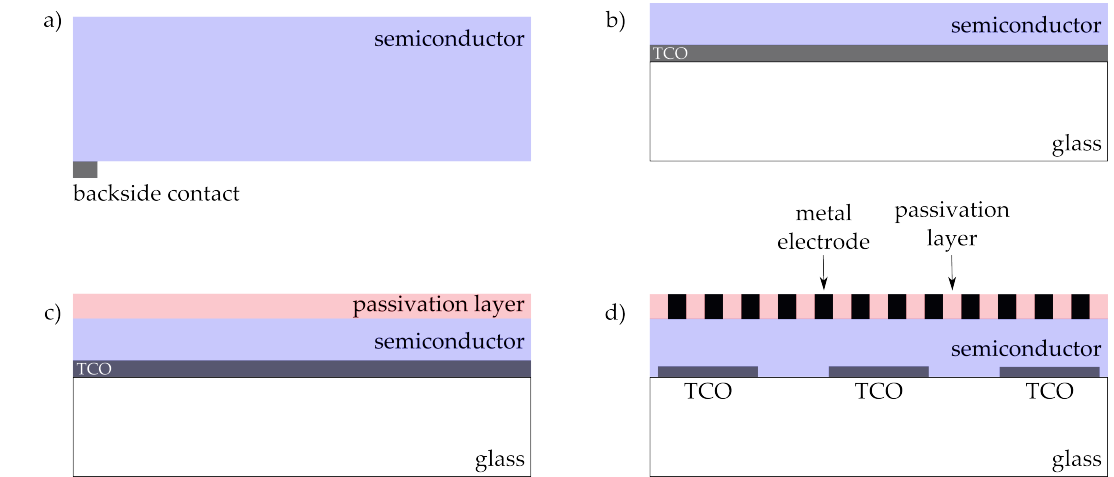
Figure 3. Different design possibilities for light-addressable electrodes: ( a ) Pure semiconductor electrically contacted, ( b ) semiconductor film deposited on a transparent conductive oxide (TCO) glass substrate for electrical connection, ( c ) deposited passivation layer for protecting the semiconductor film against environmental conditions, and ( d ) integrated metal electrodes in the passivation layer (for charge exchange) deposited on the semiconductor